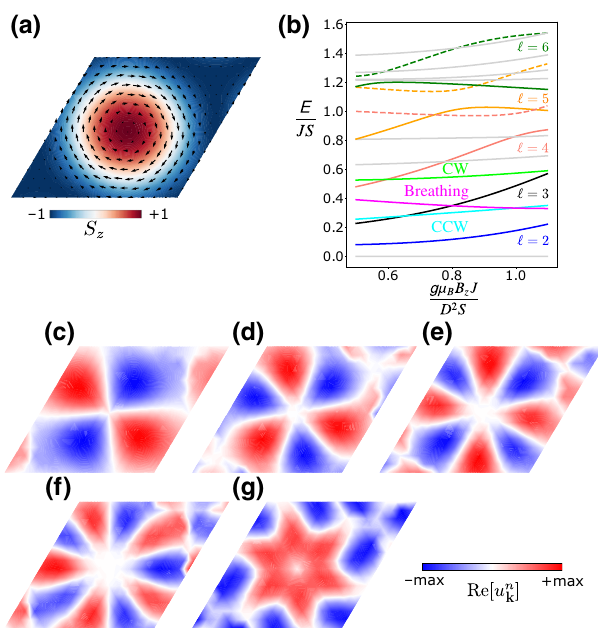
FIG. 7. Magnon spectrum of SkXs at the (cid:19) point. (a) Classical ground-state spin configuration of SkXs, obtained at D / J = 0.5 and g μ B B z J /( D 2 S ) = 0.55 under periodic boundary conditions. The magnetic unit cell consists of 16 × 16 spins on a trian- gular lattice. (b) Magnon spectrum of SkXs at k = 0 for the 18 lowest-energy eigenstates as a function of magnetic field. It highlights three magnetically active modes: CCW (cyan); breath- ing (magenta); CW (lime). In addition, the polygon modes are shown as (cid:13) = 2 (solid blue), (cid:13) = 3 (solid black), (cid:13) = 4 (solid salmon), (cid:13) = 5 (solid orange), and (cid:13) = 6 (solid green). Dashed lines indicate modes that hybridize with polygon modes for (cid:13) ≥ 4, corresponding to elliptic (dashed salmon), CCW (dashed orange), and breathing (dashed green) modes. (c)–(g) Wave